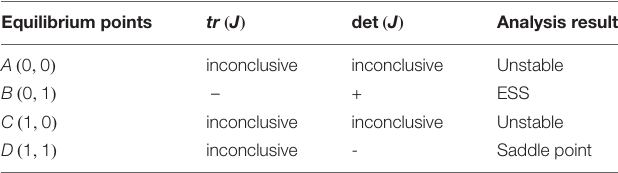
TABLE 6 | Local equilibrium stability analysis in case 2.